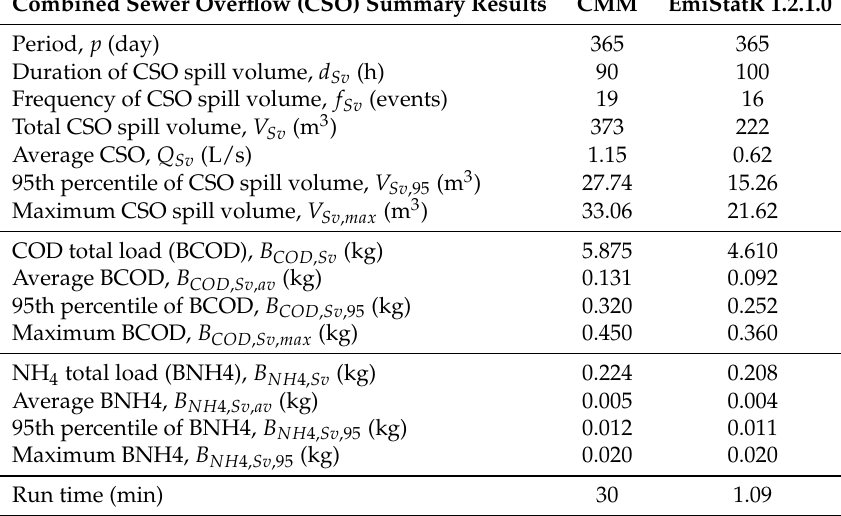
Table 4. Comparison results for the complex mechanistic model (CMM) and EmiStatR (Esch-sur-Sure rain gauge 2 h averages over 1 year